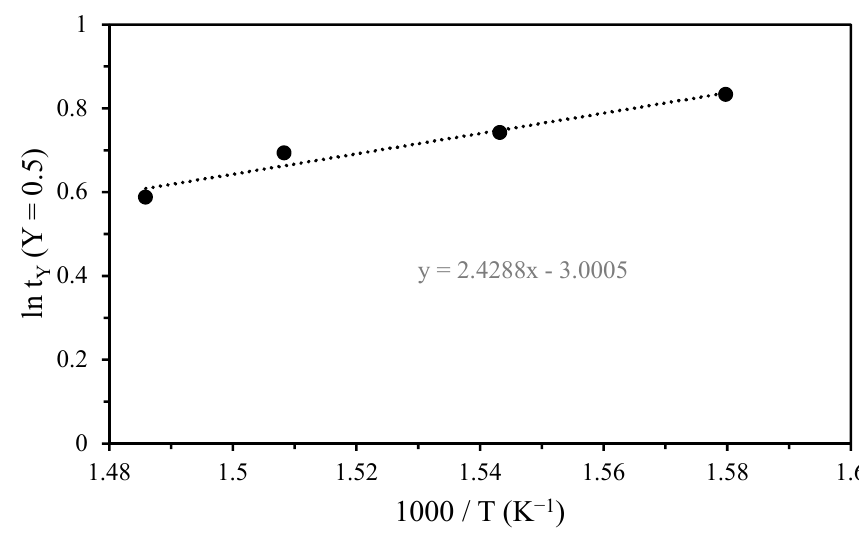
Figure 8. Arrhenius plot corresponding to the second mass t loss event (structural water).